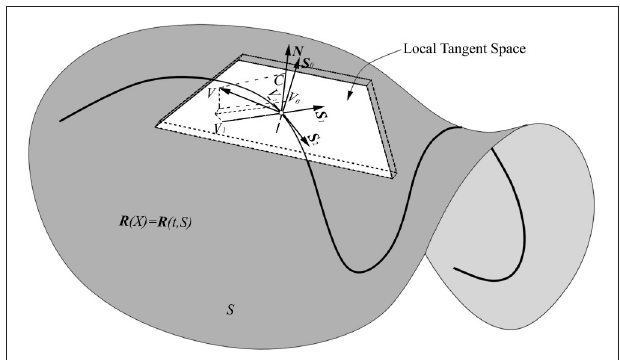
FIGURE 2 | 2D Graphical illustration of the arbitrary chosen three manifold and it’s local tangent space. S 0 , S 1 , S 2 , and N are local tangent space base vectors and the normal, respectively. V is arbitrary chosen surface velocity and C , V i , i (0,1,2) display the projection of the velocity to the N , S i =